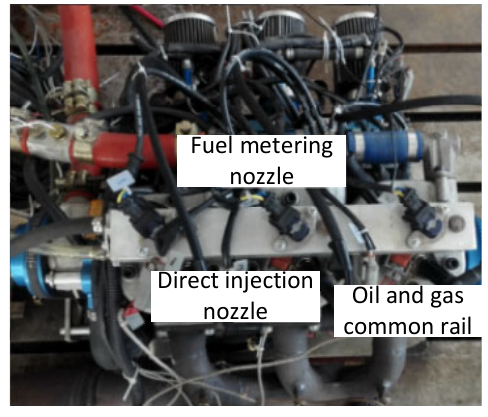
Figure 3. Basic composition diagram of experimental prototype.